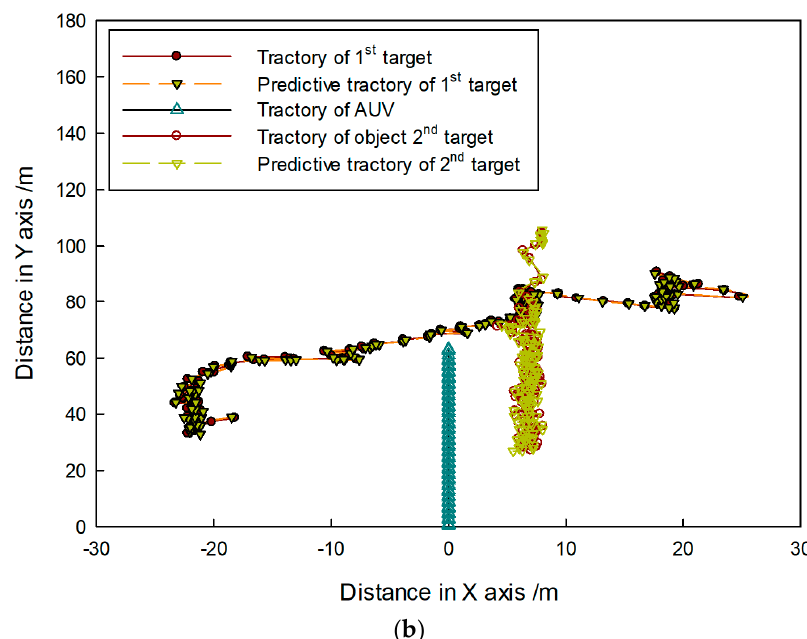
Figure 26. Target-tracking trajectory in ( a ) first and ( b ) second sequence of FLS images.